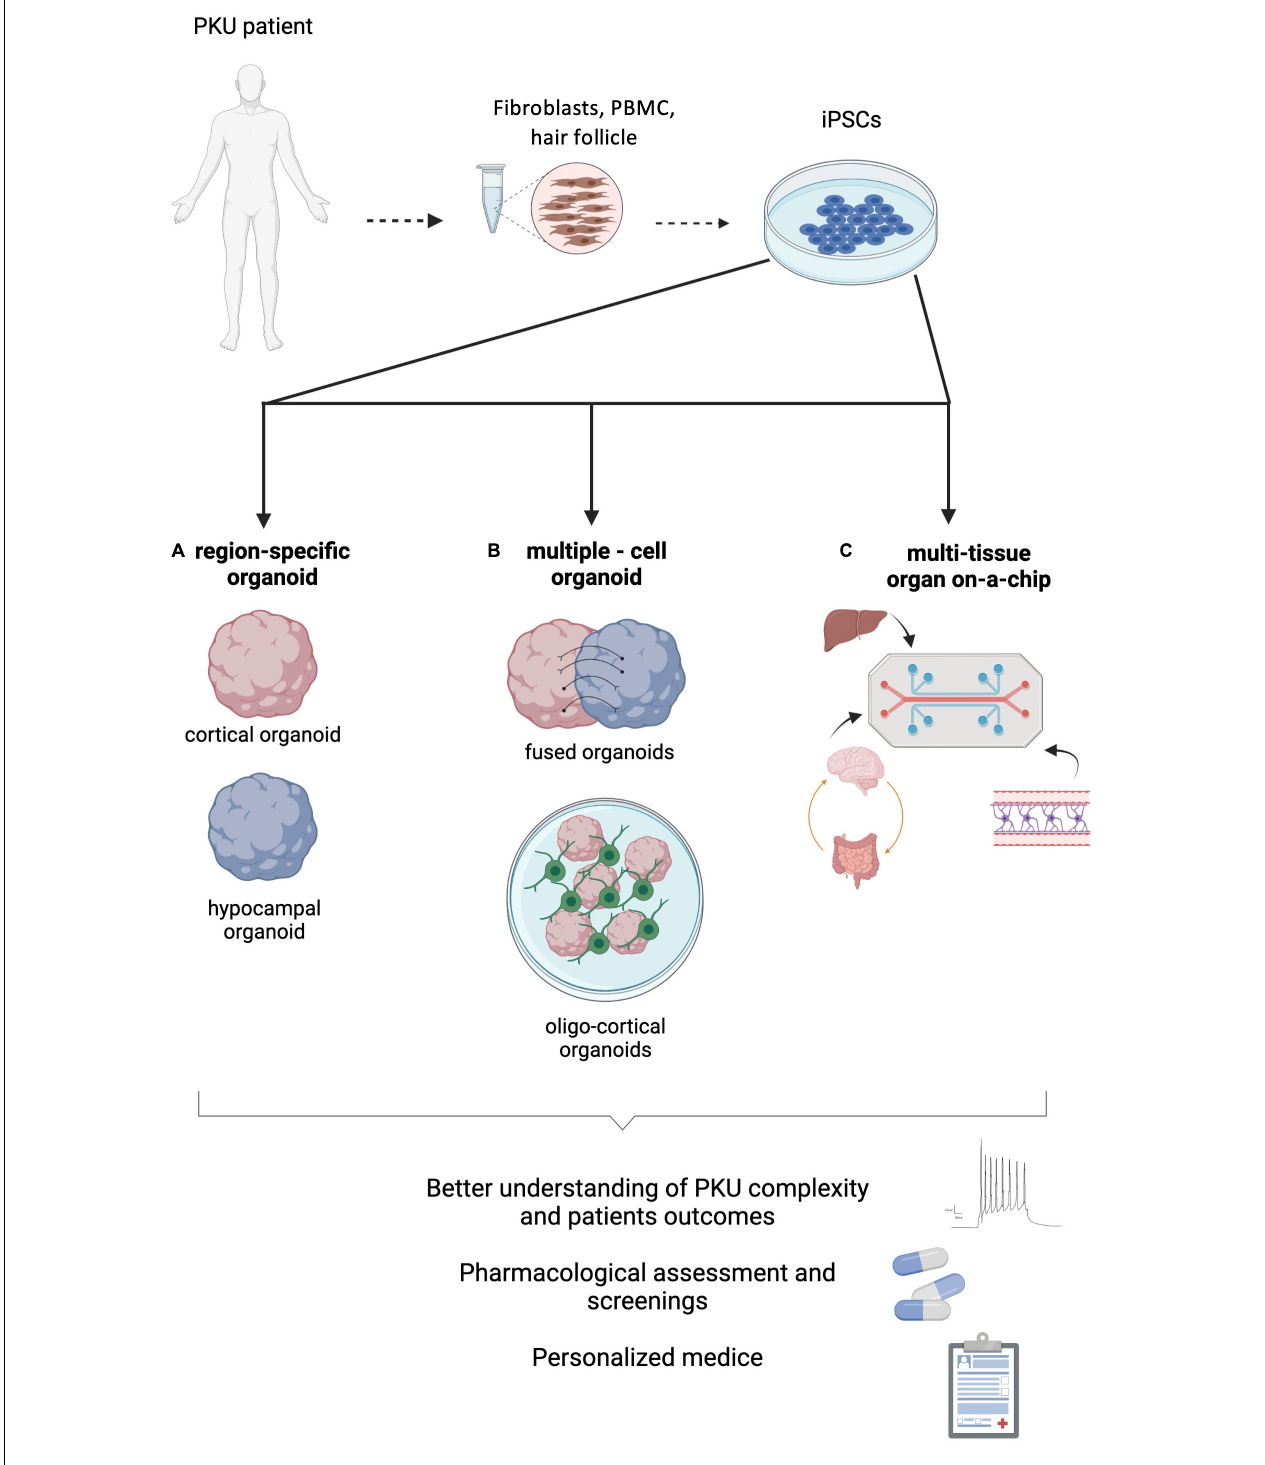
FIGURE 2 | Phenylketonuria (PKU) modeling strategies using hPSCs derived from patients. (A) Region-specific brain organoids could help clarifying specific processes directly affected by the neurotoxic effect of phenylalanine (L-Phe). (B) Multiple-cell models, such as fused-organoids or oligo-cortical organoids, might shed some light on how inter-region connectivity or myelination are impaired by hyperphenylalaninemia. (C) Multi-tissue organ-on-a-chip systems, combining the main contributors to PKU neuropathology (brain, BBB, gut and liver) will enable understanding on the systemic complexity of this disease. Figure created with